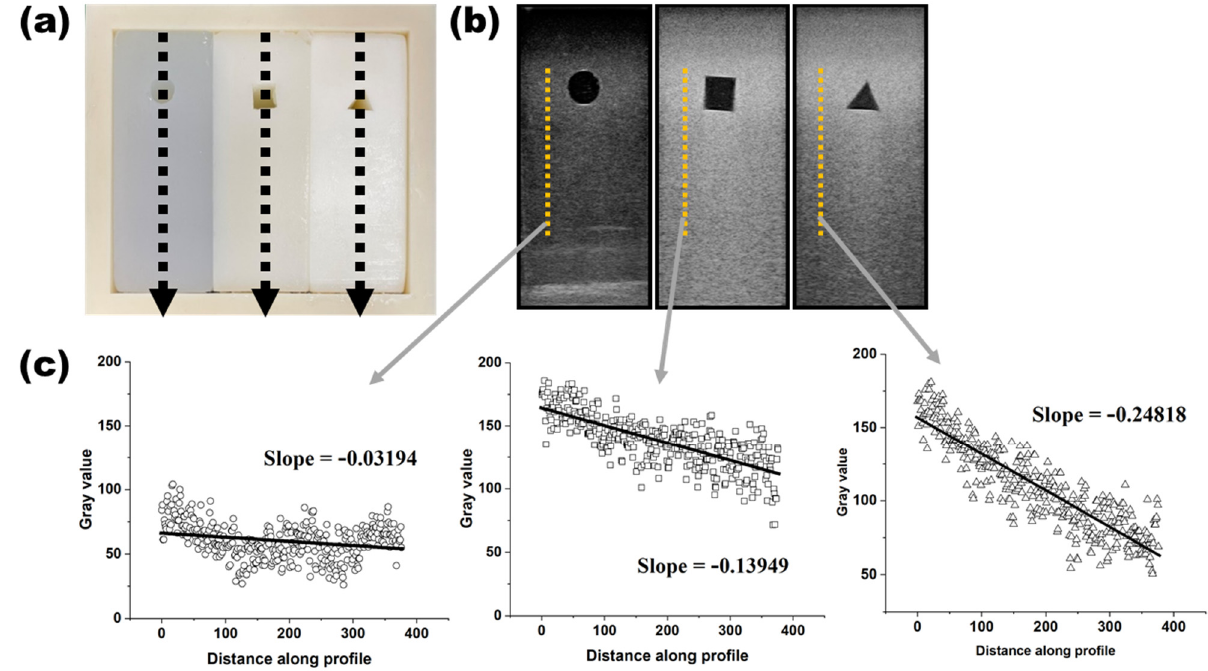
Figure 4. Intensity attenuation by fat content. ( a ) The gel phantom was inserted into the module, and the ultrasound beam was transmitted in the direction of the black dotted line. ( b ) The corresponding ultrasound image. ( c ) Line profiles in each phantom with the yellow dotted line showing the line profile. The line profile is set to the lateral side to avoid the central region artifact (acoustic enhancement).